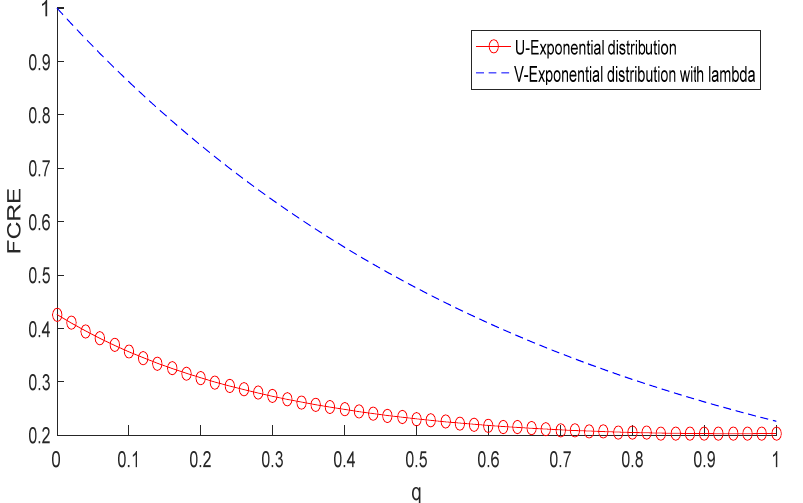
Figure 4. The fractional cumulative residual entropy of uniform distribution on [0, 1] and expo- nential distribution